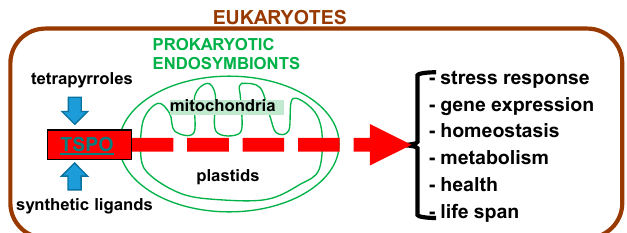
Figure 1. Overview of the subject of this review. Endogenous ligands (tetrapyrroles) as well as synthetic ligands for translocator protein (TSPO) affect functions of free living prokaryotes as well as the derived endosymbionts present as mitochondria and plastids in eukaryotes. A few of these functions modulated by TSPO and its ligands are listed on the right-hand side.